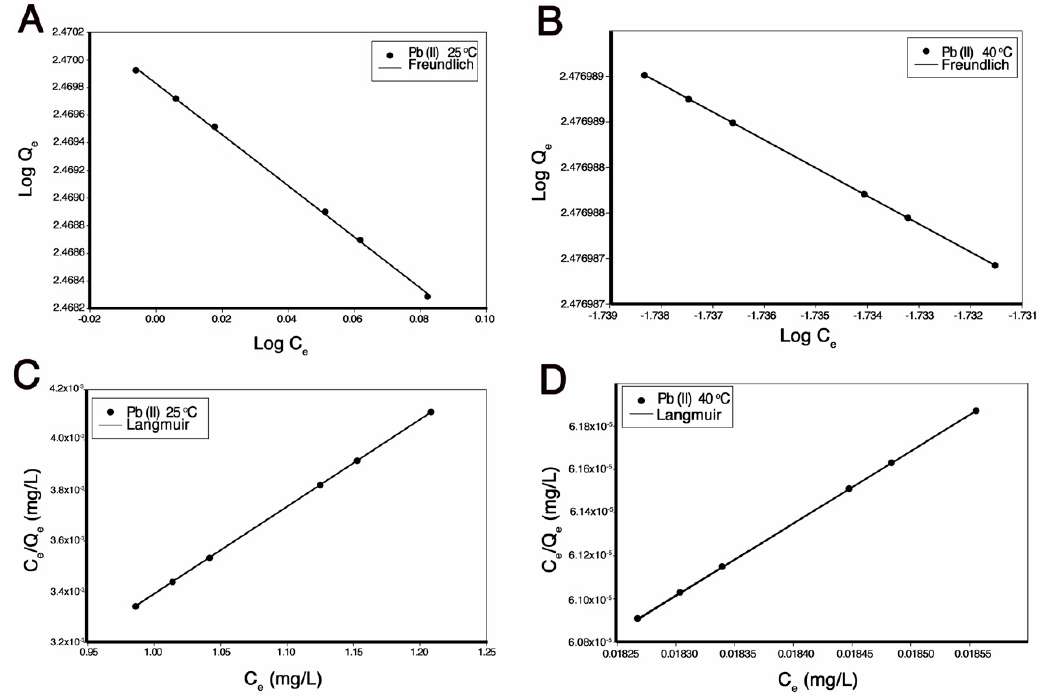
Figure 10. Adsorption isotherms of Pb(II) ions on BC/GO 2 at temperatures of 25 ◦ C and 40 ◦ C pH = 6. ( A ) Freundlich model Plot 25 ◦ C, ( B ) Freundlich model Plot 40 ◦ C, ( C ) Langmuir model Plot 25 ◦ C, ( D ) Langmuir model Plot 40 ◦ C.